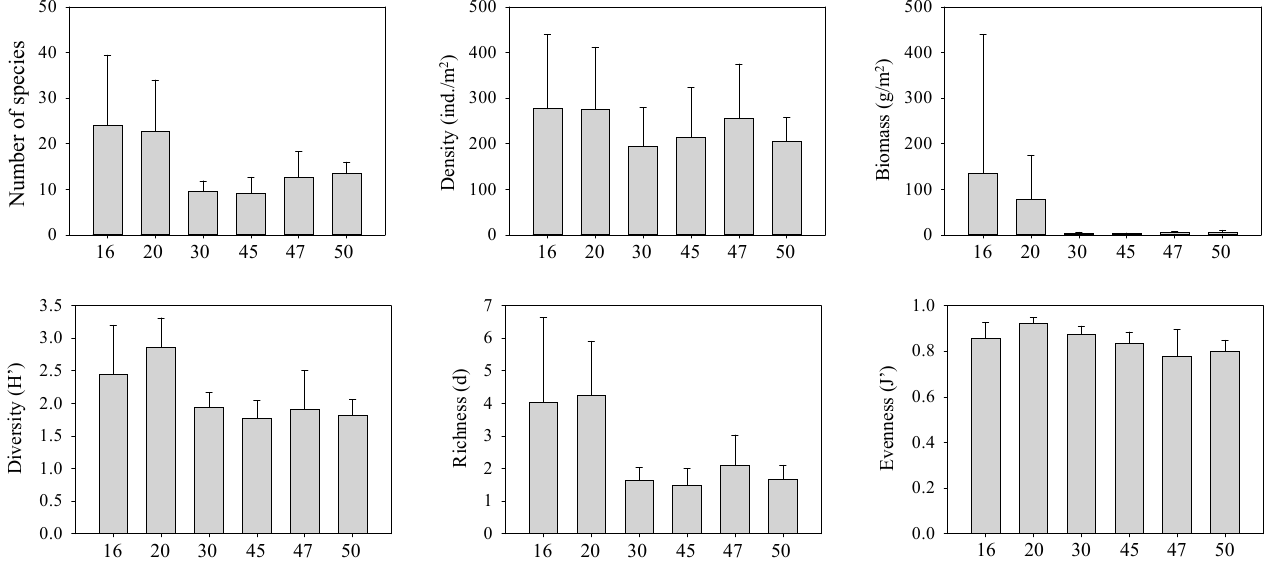
Figure 2. Macrobenthos species number; density (/m 2 ); biomass (g/m 2 ); and diversity, richness, and evenness indices.